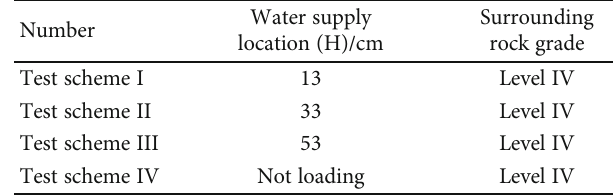
Table 1: Test scheme.